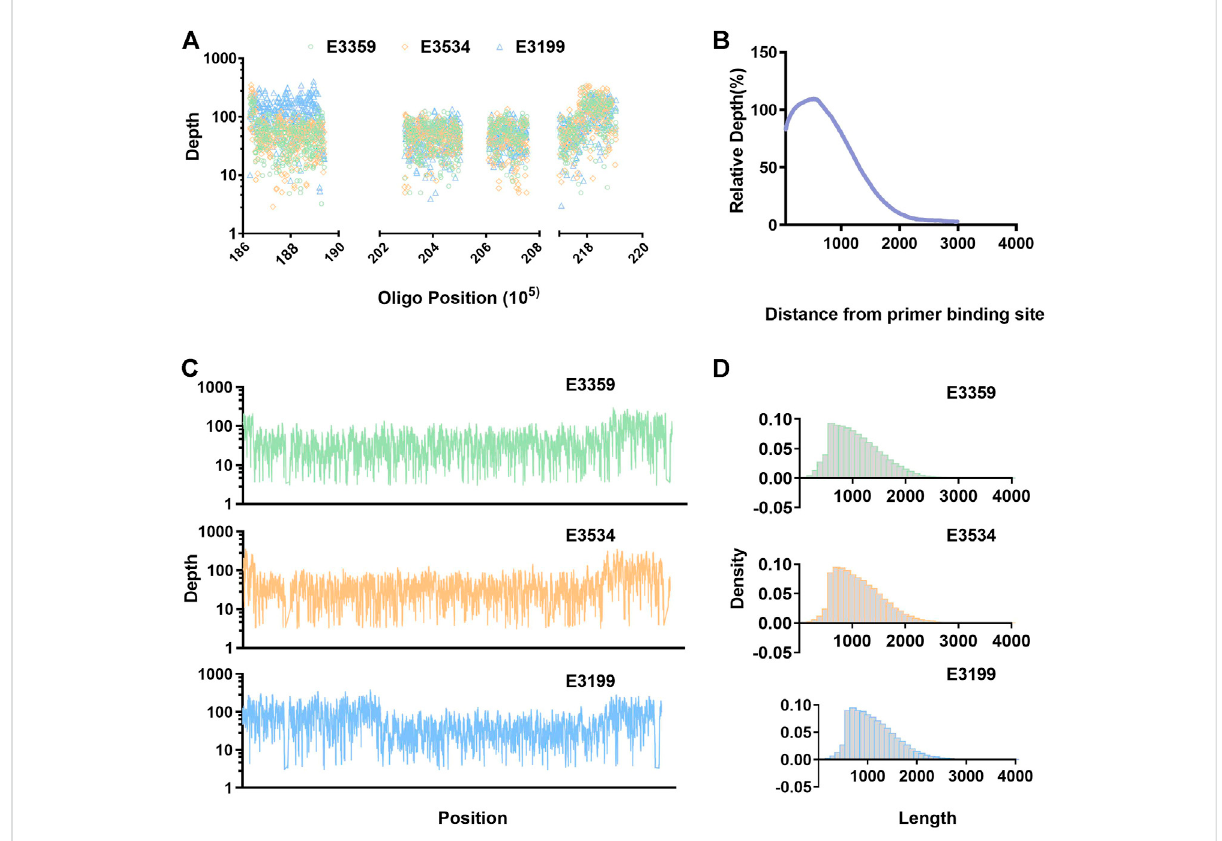
FIGURE 2 Distribution of reads. (A) Depth of coverage at the site of primers. (B) Schematic representation of the distribution of relative depth obtained after the primer hybridization site. (C) Sequencing coverage is displayed for the entire enriched about 1 Mb of the selected part 22q11.2 region. (D) Distribution of reads length.